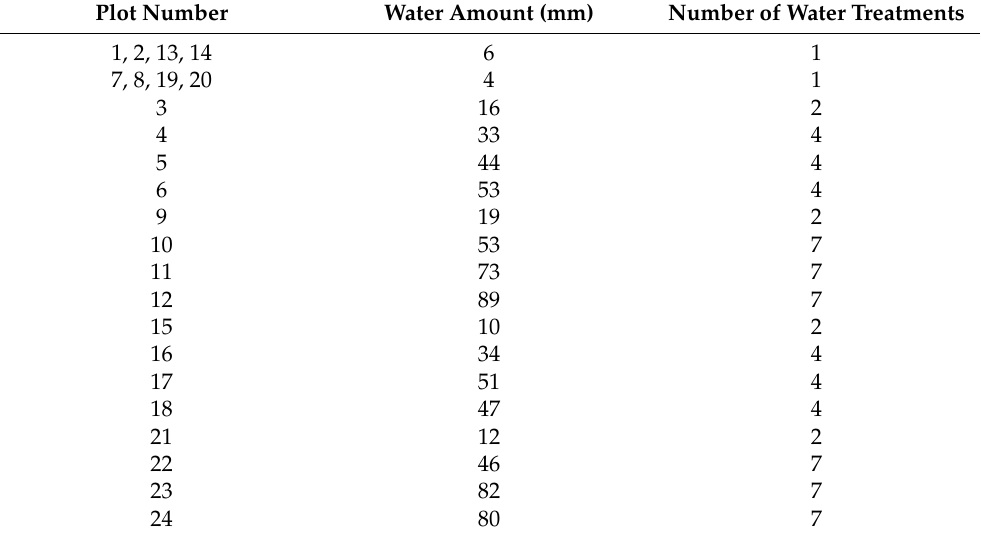
Table 1. Watering amounts during the experiment. Plot Number Water Amount (mm) Number of Water